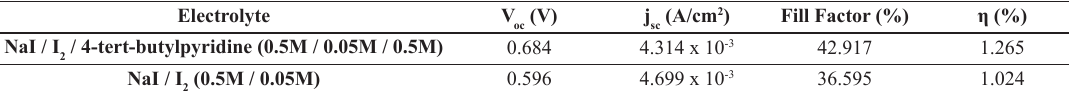
Figure 12. j x V curve for cells screening counter-ions to iodide in electrolyte solutions. Other conditions: FTO; counter electrode: graphite paste; Photoanode: TiO . 2